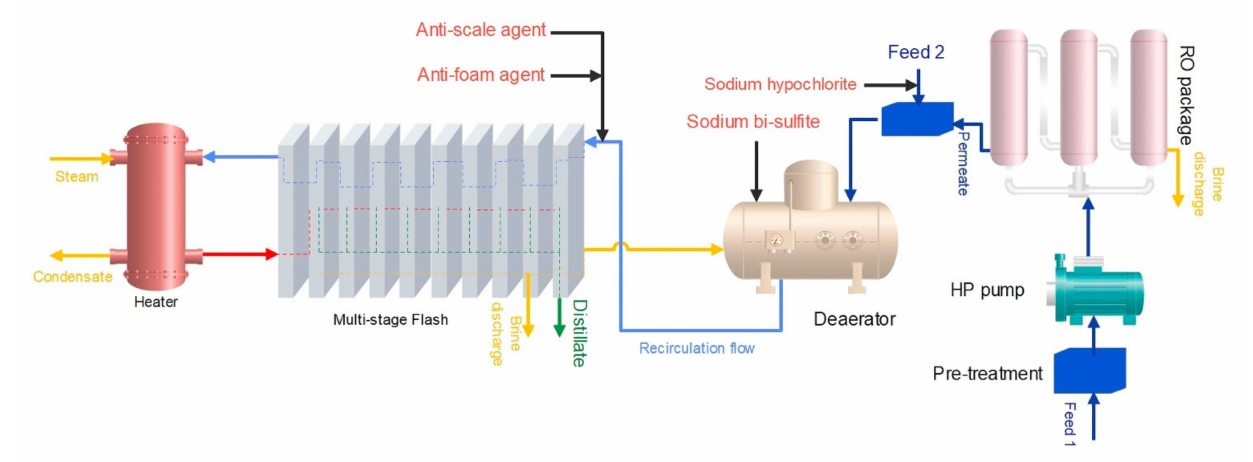
Figure 3. The schematic of case 1 (hybrid RO/R-MSF Flash).